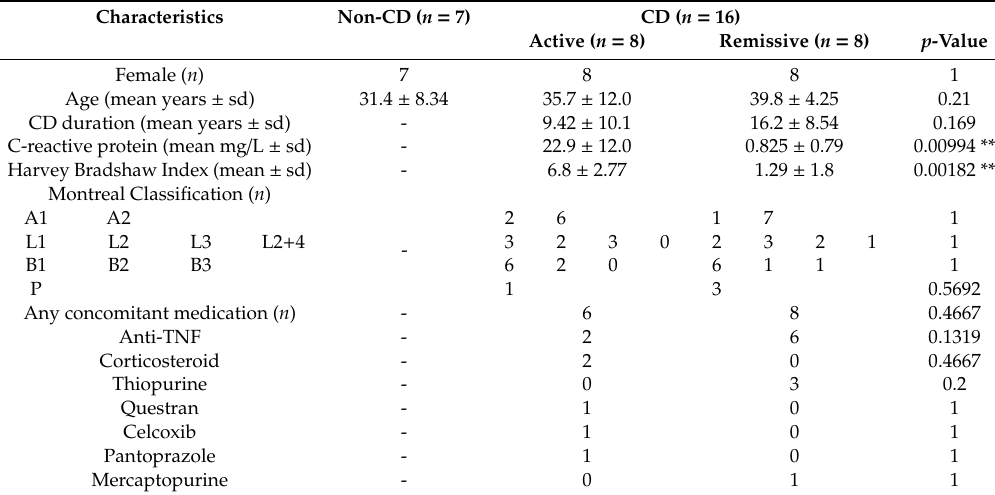
Table 1. Summarized patient characteristics. p -values were calculated through two-sided Fisher tests for binomial data and two-way ANOVAs for continuous data. Fisher tests among the medications were only performed between active and remissive CD patients. ** p -value <